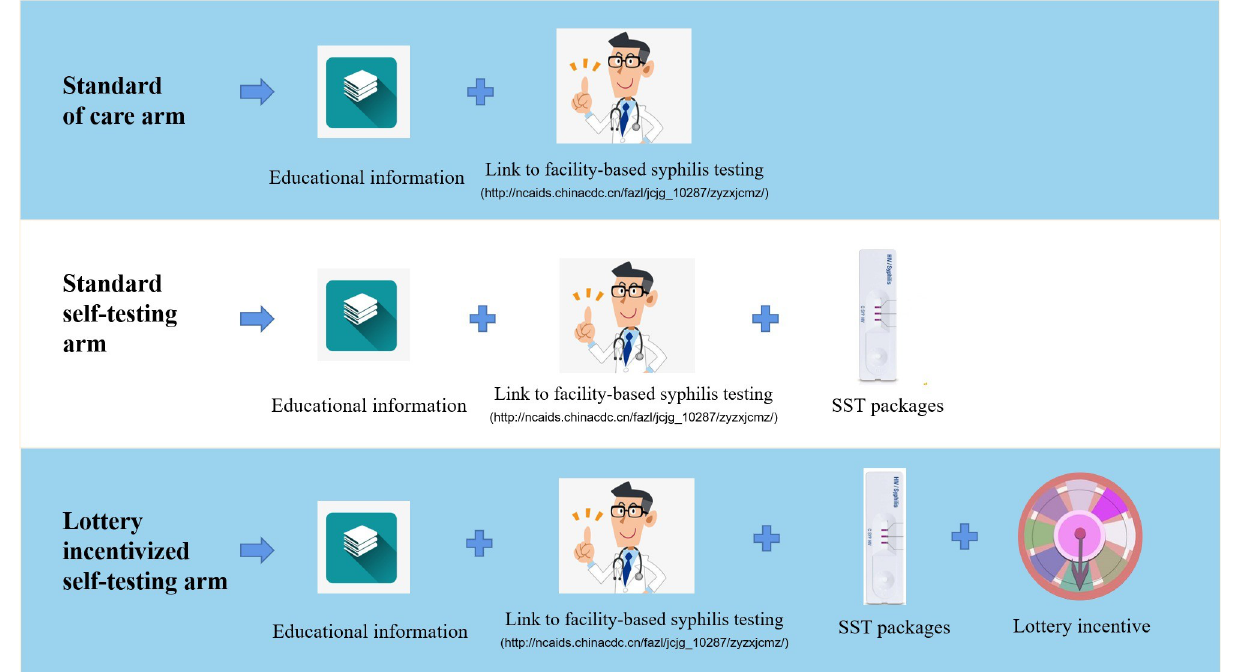
Fig 1. Key concepts of the 3 study arms: standard of care, SST, and lottery incentivized self-testing. S AU : AbbreviationlistshavebeencompiledforthoseusedthroughoutFigs 1 and 2 : Pleaseverifythatallentriesarecorrect : ST, syphilis self-testing.